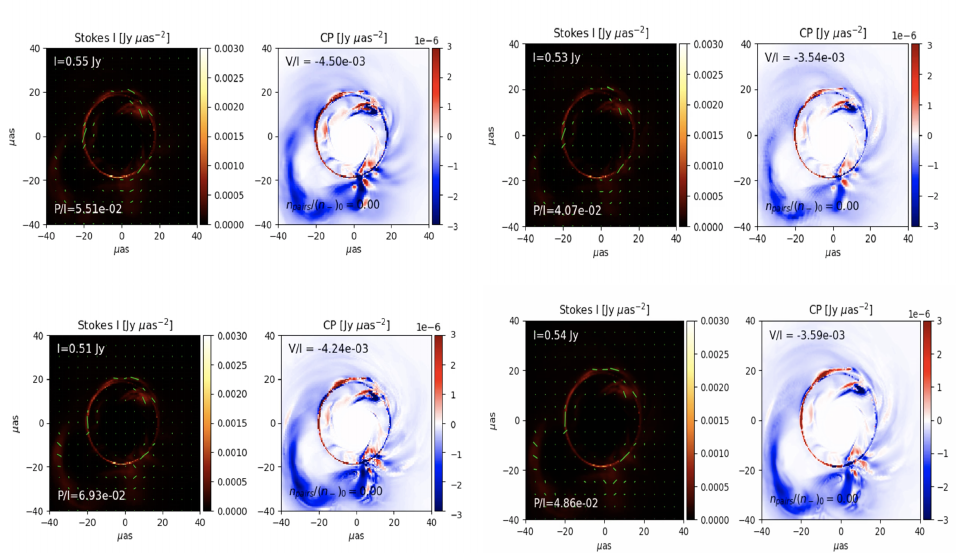
Figure 8. For the a = − 0.5 MAD at 230 GHz and at T = 25,000 M : ( Top Left ) R-Beta Model; ( Top Right ) R-Beta with a β e 0 = 0.01 jet; ( Bottom Left ) Critical Beta Model; ( Bottom Right ) Critical Beta with a β e 0 = 0.01 jet. For each case, the intensity is overplotted with the electric vector polarization angle on the left panel, and the circular polarization degree is mapped on the right panel.